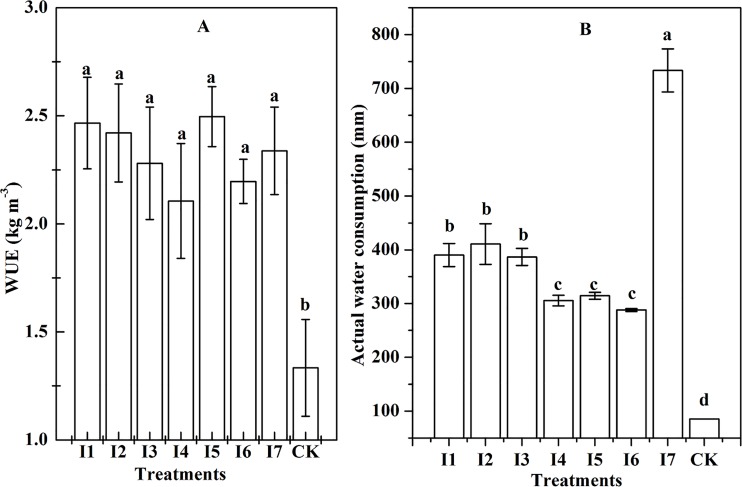
The WUE and water consumption of different treatments (P < 0.05).(A) Result of the water use efficiency (WUE) of different irrigation treatments; (B) the actual water consumption of the eight treatments. Lowercase letters indicate the results of ANOVA at α = 0.05; in addition, the double asterisks show that the confidence interval is α = 0.05.